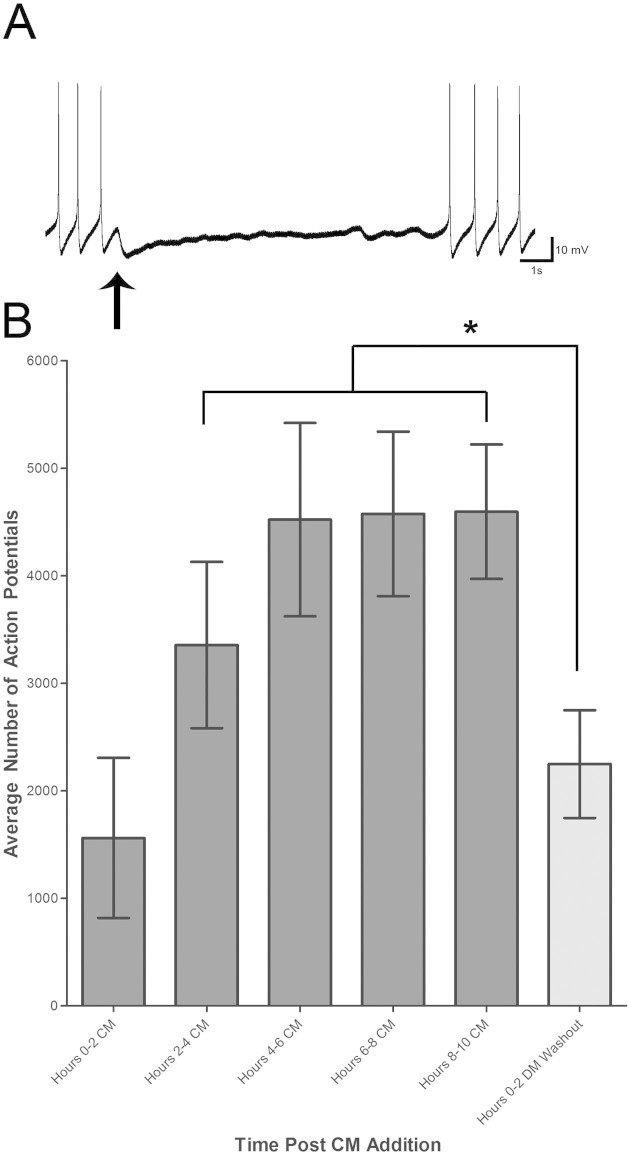
LPeD1 hyperpolarization inhibits excitatory nAChR expression and the presence of trophic factors is necessary to maintain activity in LPeD1.To determine whether activity is important for the expression of excitatory nAChRs, an intracellular sharp-electrode was used to inject hyperpolarizing current into LPeD1 neurons maintained in CM. (A) We found that the neurons hyperpolarized for 8 hours remained robust as demonstrated by their ability to elicit action potentials. However after blocking trophic factor induced activity, the LPeD1 neurons failed to express excitatory nAChRs despite being exposed to CM. Exogenous application of ACh (thin arrow) confirmed this by showing a reduction in spontaneous activity with each application. (B) Next, to determine whether the maintenance of activity in LPeD1 is CM dependent, the solution was washed out with DM after 10 hours of CM exposure. We found that following the CM withdrawal, LPeD1 activity significantly decreased to a level similar to that observed in the initial two hours following CM exposure. Significant differences are denoted with an asterisk (*) and is assumed if p < 0.05.